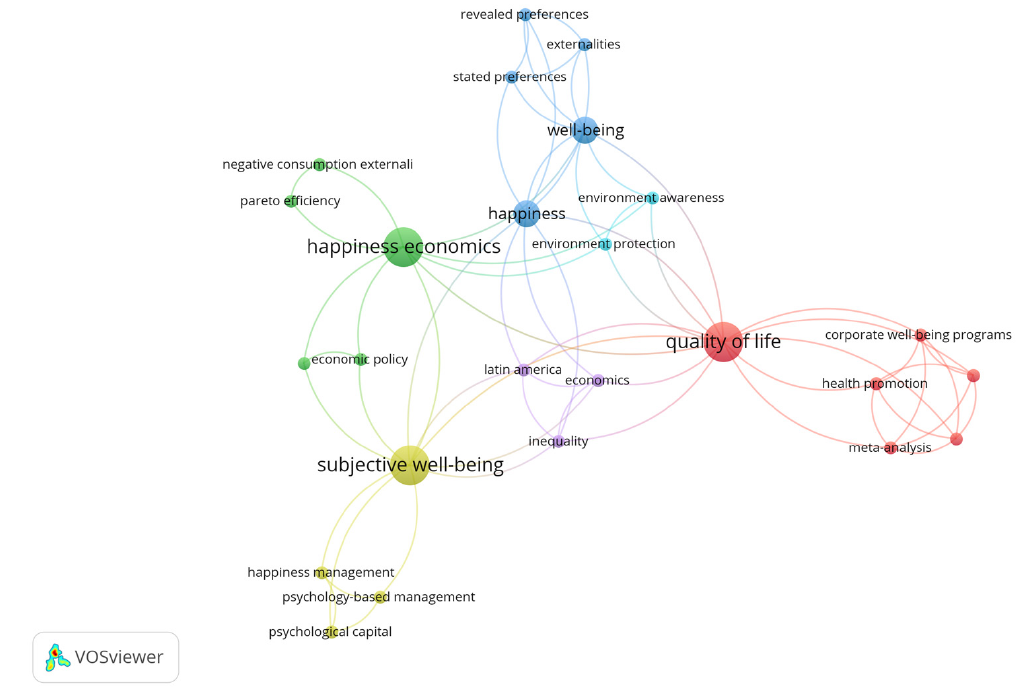
Figure 4. Keyword co-occurrence maps; period: 2005–2010.